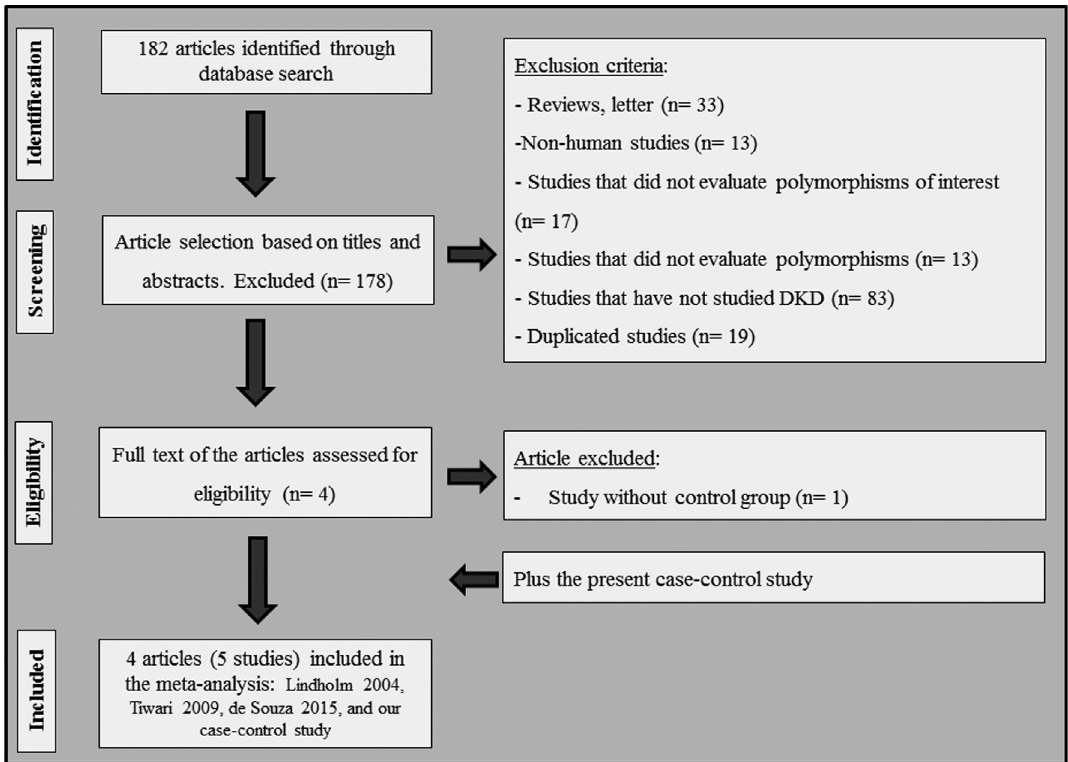
Figure 2 - Flow diagram illustrating the search strategy used to identify association studies of UCP2 polymorphisms and DKD for inclusion in the meta-analysis study.